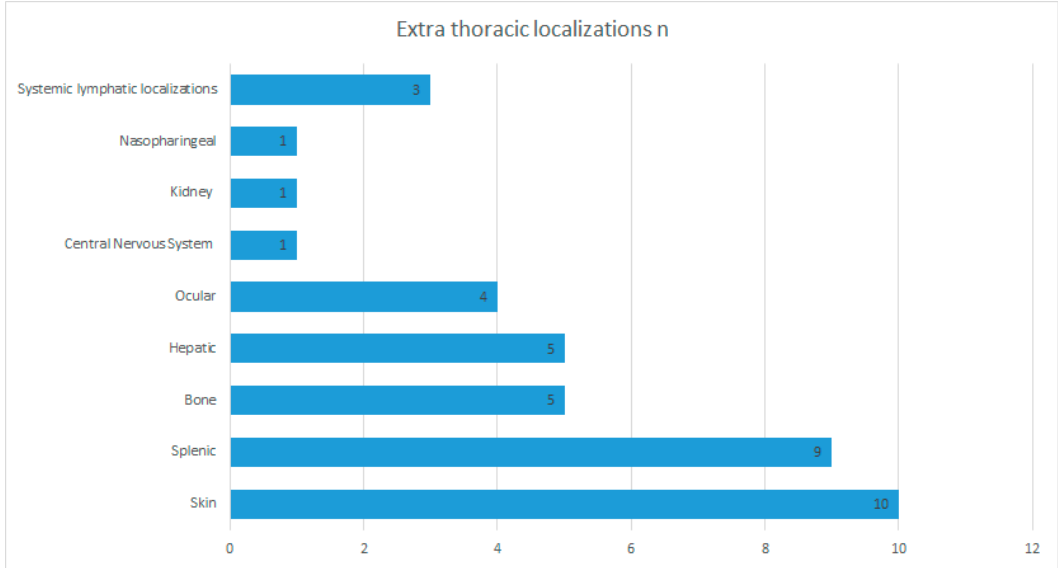
Figure 7. Proportion of extra-thoracic localizations.